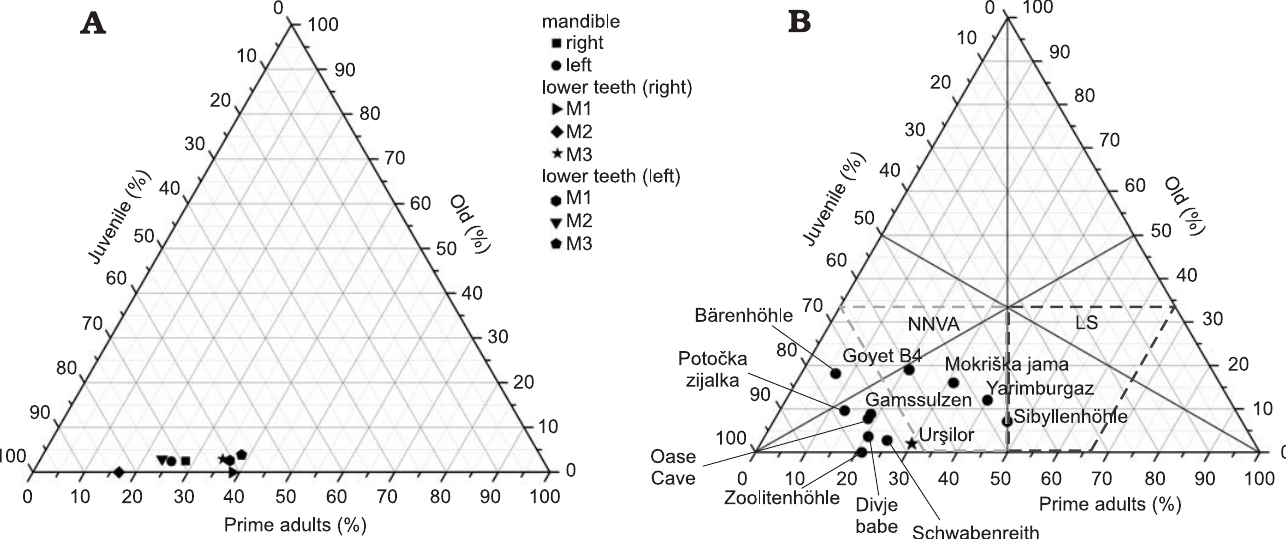
Fig. 3. Tripolar graphs showing the distribution of the teeth and mandibles ( A ) of cave bears from Ur ş ilor (~45–40 calendar kyrs BP) in the three main age categories (according to Stiner 1994); and distribution of age classes ( B ) from different cave bear sites in the three main age categories, as proposed by Stiner (1994): NNVA (Normal Non-Violent Assemblage), grey dashed polygon; LS (Living age Structure), black dashed